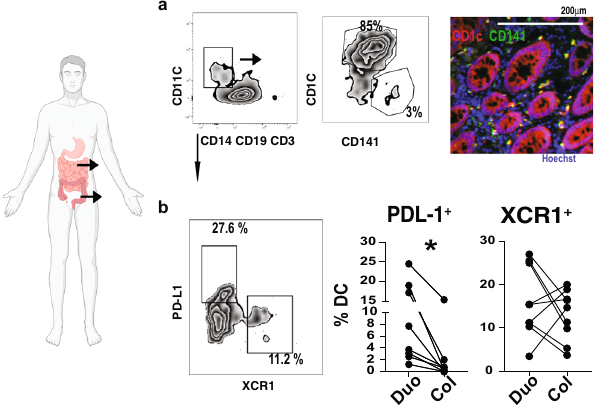
Fig. 6 PD-L1 + and XCR1 + DCs isolated from duodenum and colonic human biopsies. a Flow cytometry dot plots from duodenal and colonic human biopsies showing DC phenotype, and immuno fl uorescence showing CD1c and CD141 colocalization in colonic biopsies (20X). b Graphs represent the percentage of PD-L1 + and XCR1 + DCs gated on singlets, live, HLA-DR High , dump − (CD19, CD3, CD14) and CD11c + cells; N = 8, paired two-tailed Student ’ s t test, * p = 0.031. Source data are provided as a Source Data fi le. Biorender was used for